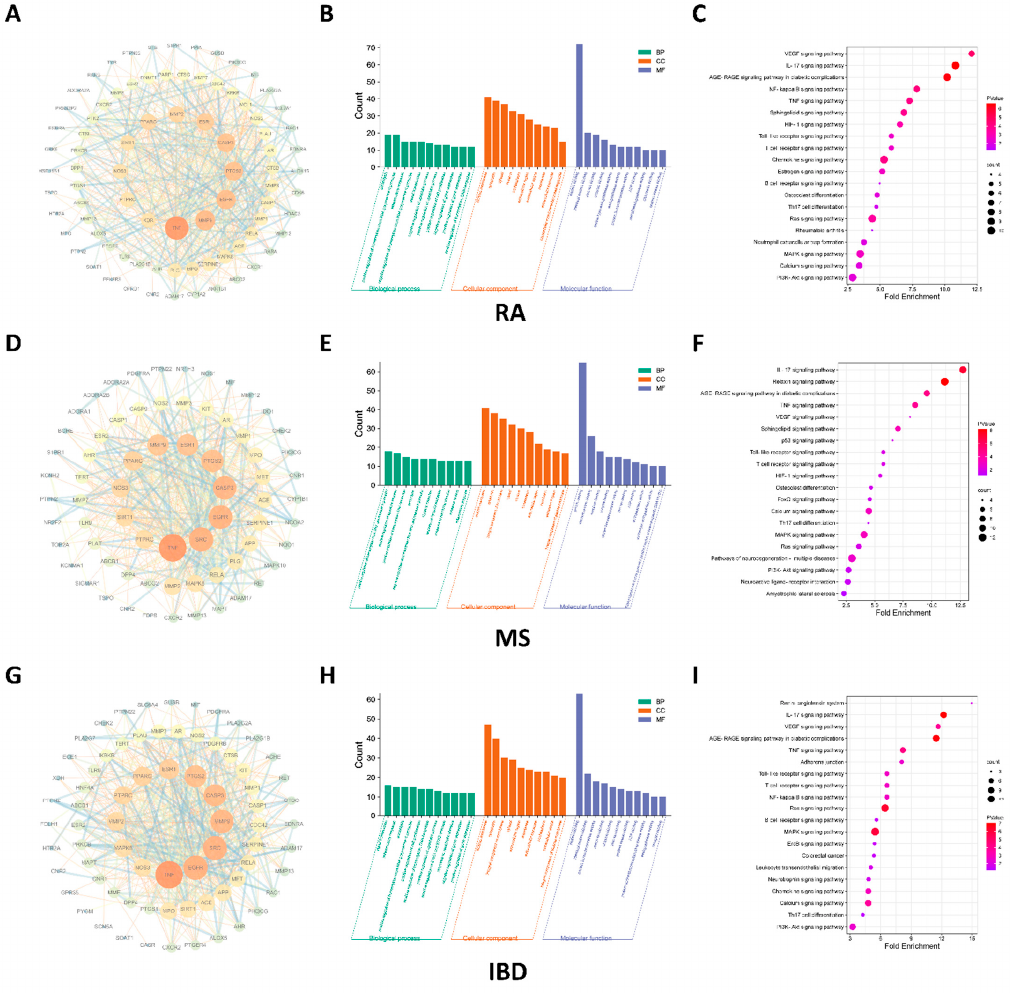
Figure 2. PPI network regarding shared targets of NEO and RA ( A ), MS ( D ) and IBD ( G ); GO anal- ysis of shared targets of NEO and RA ( B ), MS ( E ) and IBD ( H ); KEGG analysis for signaling pathway of shared targets of NEO and RA ( C ), MS ( F ) and IBD ( I ).